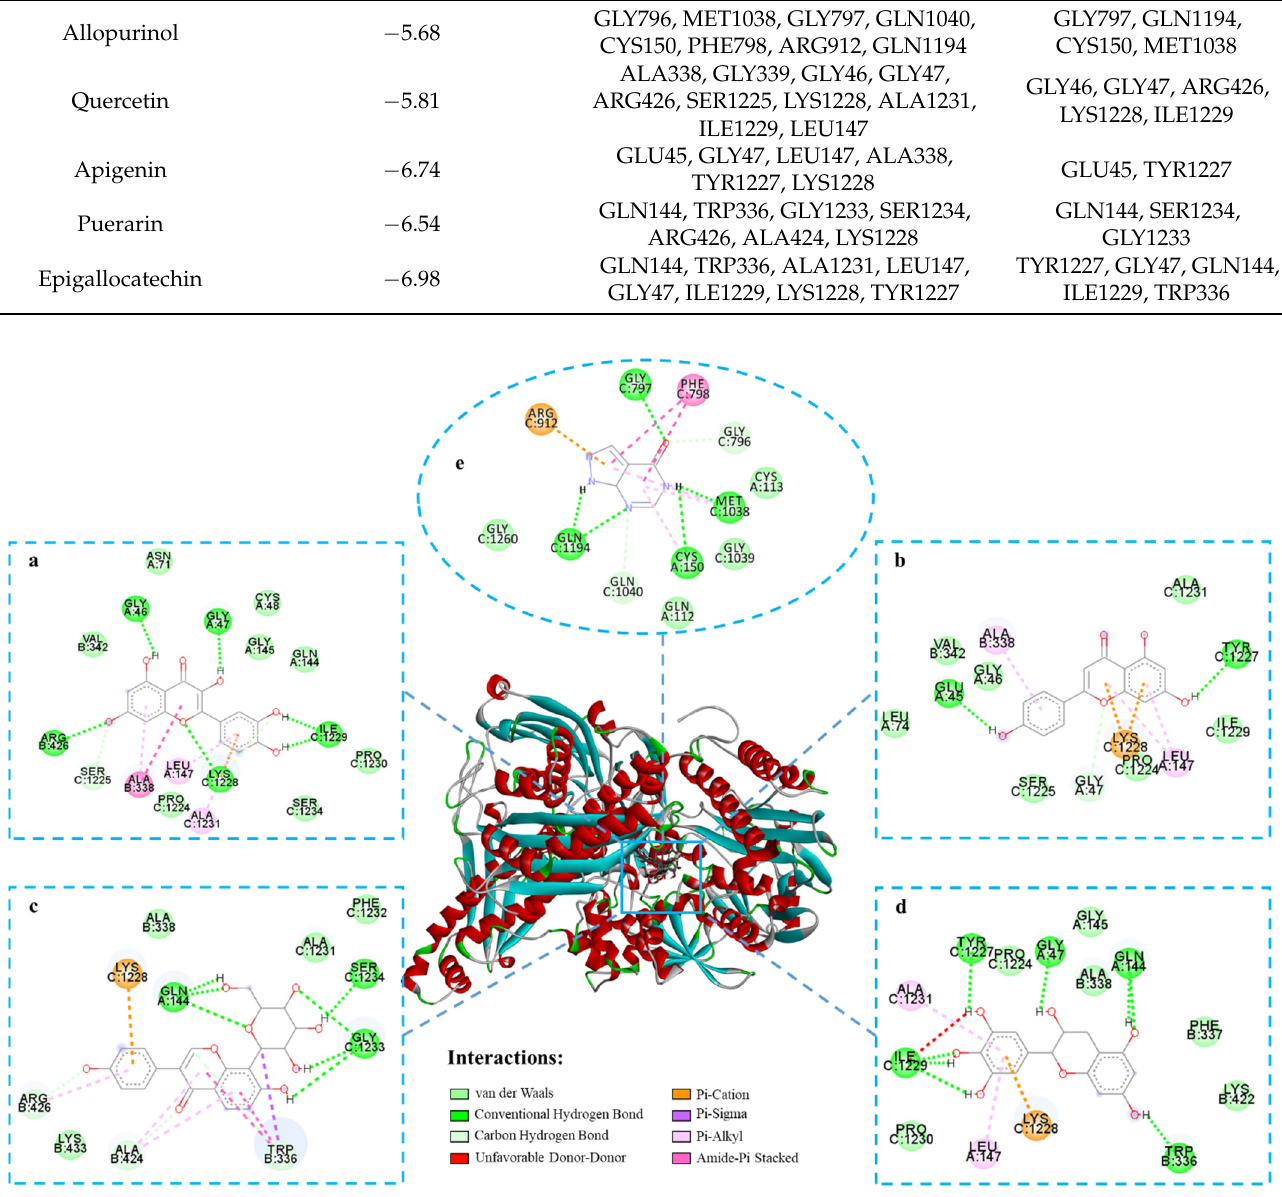
Figure 7. Molecular docking of quercetin ( a ), apigenin ( b ), puerarin ( c ), epigallocatechin ( d ) and allopurinol ( e ) with XOD.